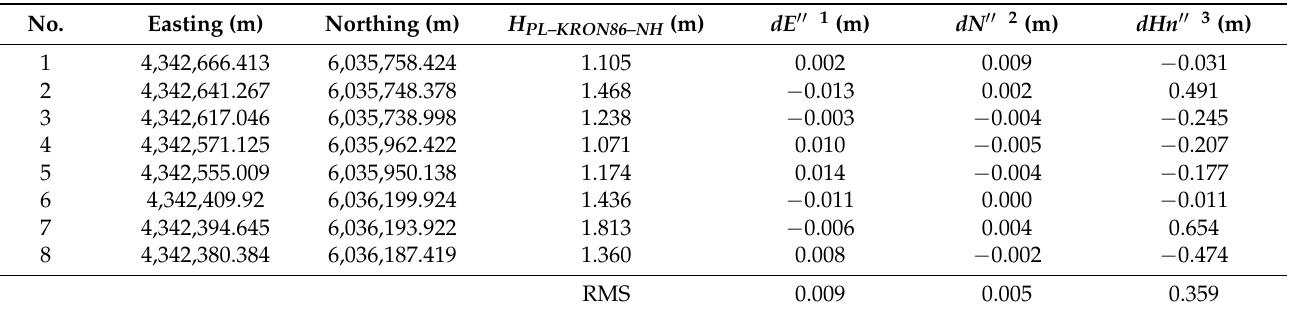
Table 11. Measurement point coordinates determined by the adjustment calculus method and their differences in relation to the reference point